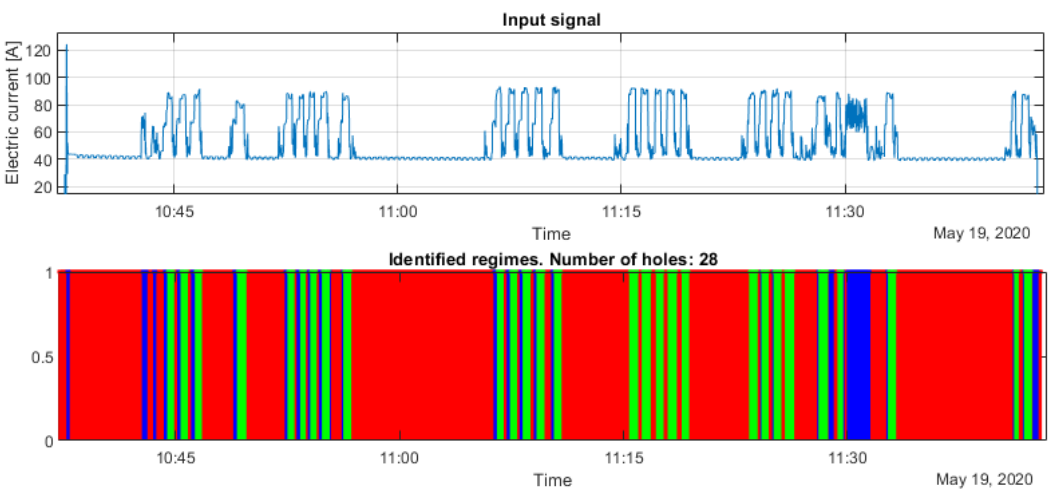
Figure 9. Segmentation results. Red: idle state, blue: pre-boring or ill-defined action, green: drilling.